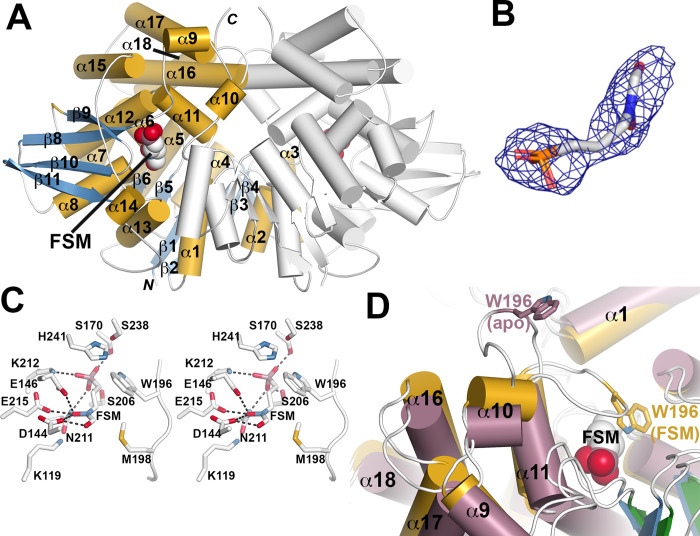
Crystal structure of S. schleiferi DXR.(A) Overall structure of the S. schleiferi DXR•FSM complex. The dimer is shown as a ribbon diagram with α-helices and β-strands of one monomer colored gold and blue, respectively. The position of FSM (space-filling model) in one monomer is indicated. (B) Electron density for FSM is shown as a 2Fo-Fc omit map (1 σ). (C) Stereoview of FSM binding in the active site. Dotted lines indicate protein-ligand interactions. (D) Comparison of S. schleiferi DXR apoenzyme and FSM complex structures. Structural changes in the active site region between the apoenzyme (rose) and FSM complex (gold) are shown. The major change in the position of the α10-α11 loop is emphasized by the position of Trp196 in each structure.